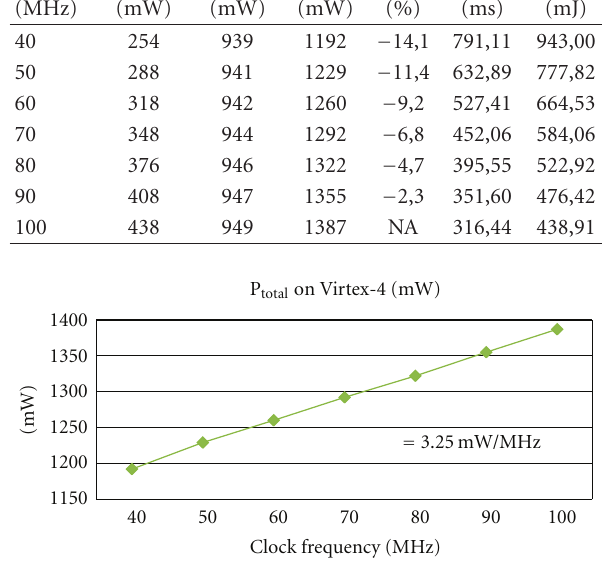
Figure 15: Impact of the clock frequency to the total power consumption of a uniprocessor on a V4FX100.